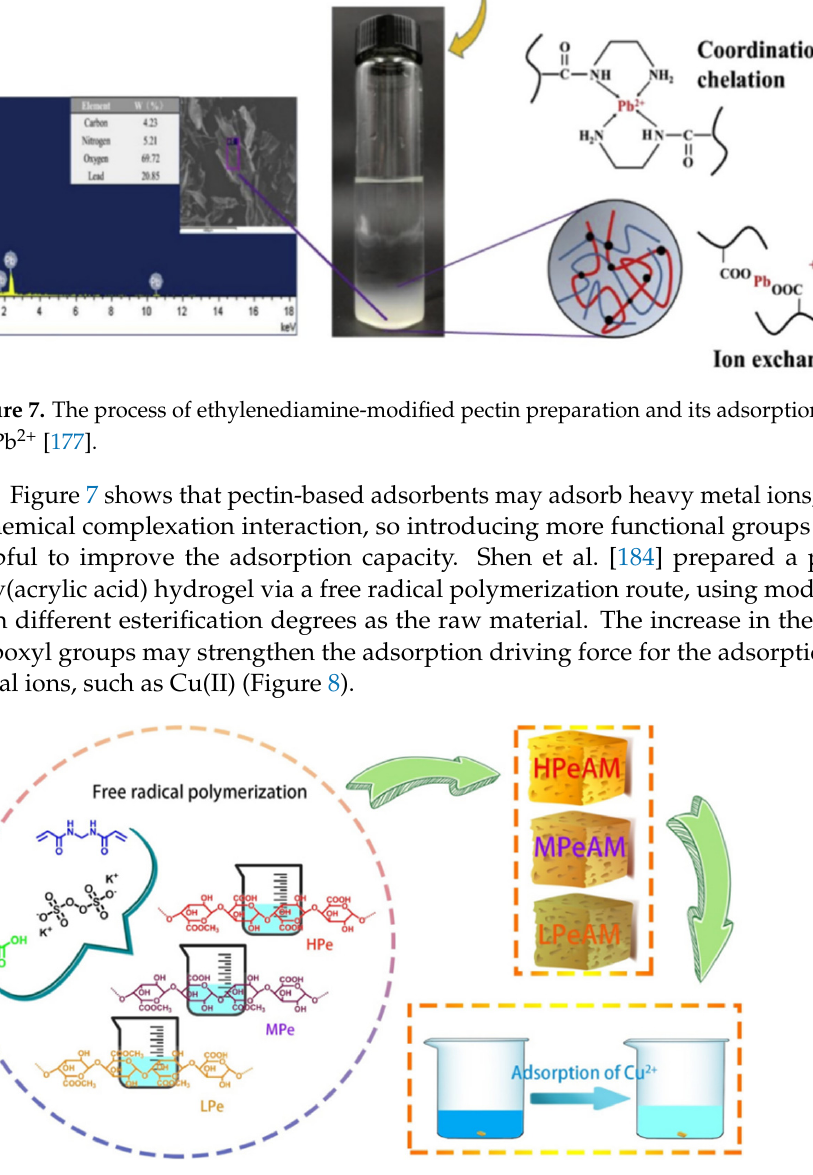
Figure 8. The preparation process of pectin-based adsorbent by a grafting polymerization reaction and its adsorption process for Cu(II) [184].